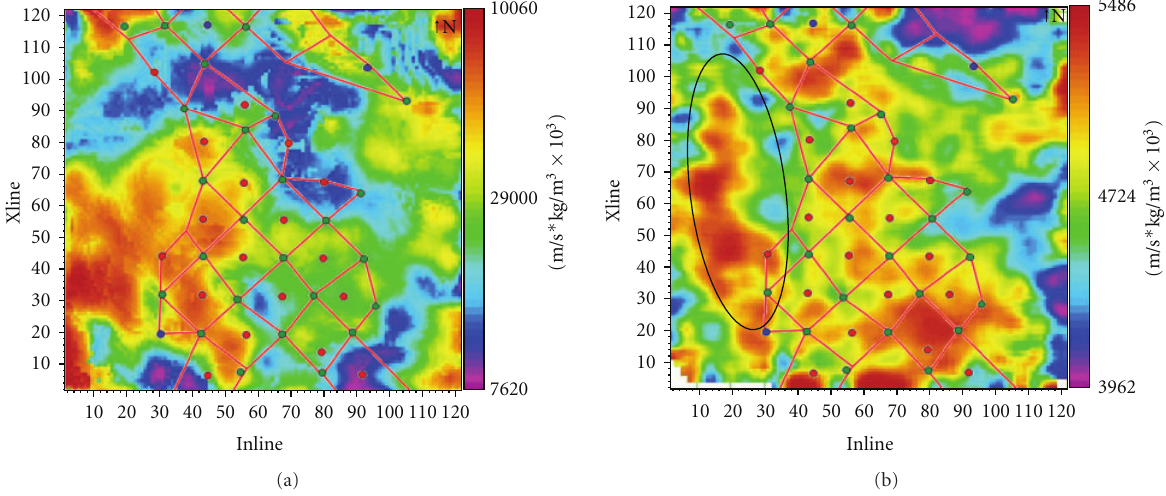
Figure 22: (a) P-wave impedance map and (b) S1-wave impedance map (right) are shown with well pattern overlaid on them (green dots represent producer wells; red dots represent injector wells). For P-waves, the impedance map is obtained by computing rms amplitude in a 0.009s window centered on Morrow A sandstone. For S1-waves, the impedance map is obtained by computing rms amplitude in a 0.01s window centered on Morrow A sandstone [35]. The S1-wave impedance shows better match with the well pattern. The high impedance in the west part of the study area (shown by black oval) ties with the presence of A1 sandstone (Figure